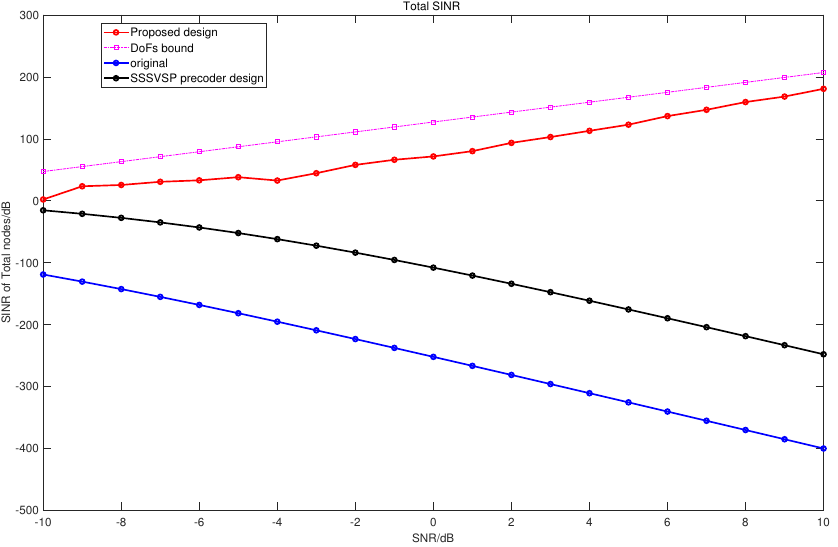
Figure 3. The total SINR, which is the sum of SINR values at all receivers for the proposed design, DoF bound, SSSVSP, and original signal for coexistence between the radar and communication network.